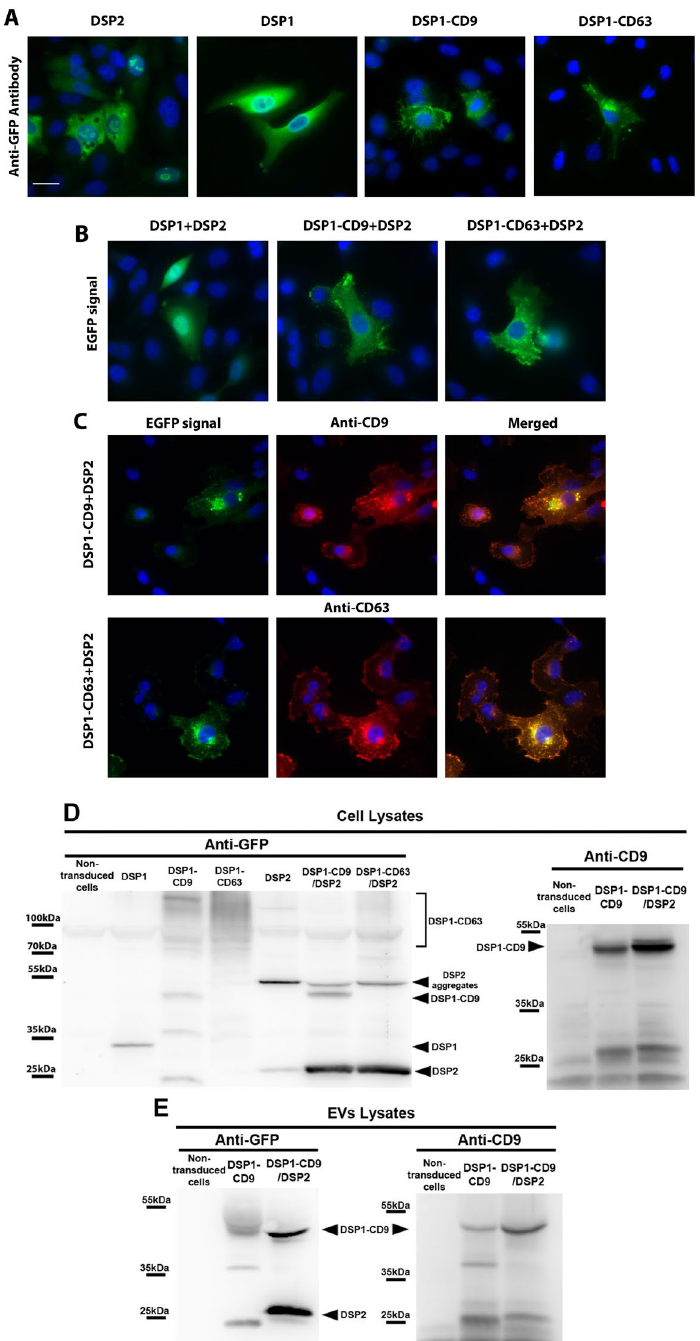
Figure 1. Characterization of DSP constructs. ( A ) Subcellular localization of the different DSP constructs. SUM159 cells were transiently transfected with the indicated DSP constructs and stained with α -GFP rabbit polyclonal Ab. (B) Dual Split Proteins reassociation detected by fluorescence microscopy. SUM159 cells were co- transfected with DSP1 + DSP2, DSP1-CD9 + DSP2 or DSP1-CD63 + DSP2 and EGFP signal was observed by fluorescence microscopy 48 h after transfection. (C) Staining of DSP contructs with anti-tetraspanin antibodies. SUM159 cells were co-transfected with DSP1-CD9 + DSP2 or DSP1-CD63 + DSP2 and stained with VJ1/20 anti-CD9 or Tea3/10 anti-CD63 mAbs, respectively. EGFP signal and anti-tetraspanin stainings were observed by fluorescence microscopy 48 h after transfection. All samples were co-stained with DAPI. Images were acquired in a wide-field epifluorescence microscope. Bars = 20 μ m. (D) SUM159 cell lines that stably express each DSP construct were obtained by transduction with a pLVX lentiviral vector, lysed and subjected to SDS-PAGE. (E) Lysates from EVs isolated by ultracentrifugation at 100000 g from SUM159 expressing DSP1-CD9 or DSP1-CD9/DSP2 conditioned media. Membranes were blotted with α -GFP rabbit polyclonal antibody or α -CD9 (VJ1/20) mouse mAb. Positions of molecular weight markers and the different specific bands are